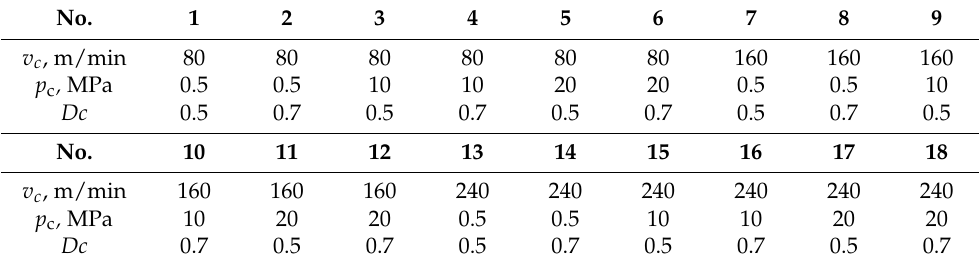
Table 4. Experimental setup for HUVC machining of Inconel 718. No.